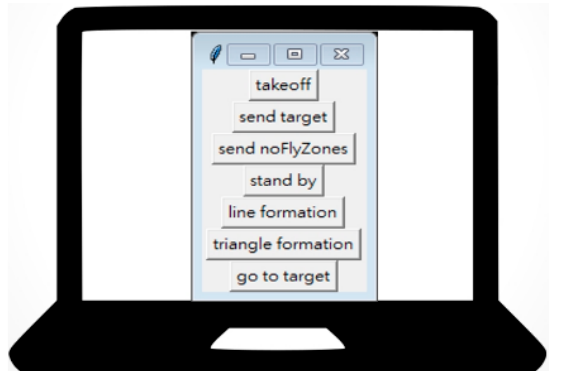
Figure 3. Small ground station.